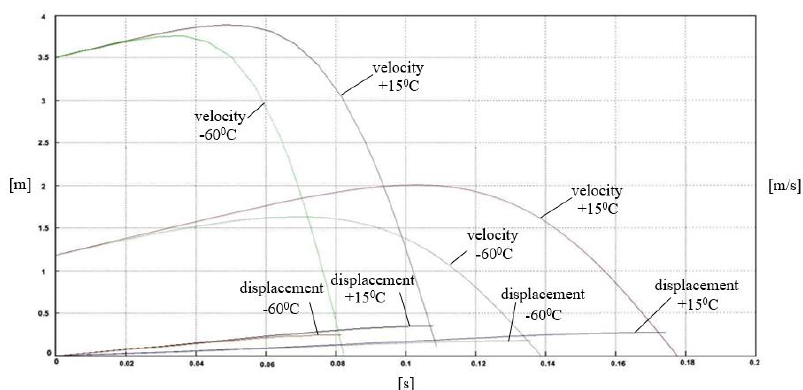
Figure 14. Displacement (blue line) and velocity of the buffer (orange line) at an operating higher speeds the percentage of the increase is lower. temperature of −60 °C, an impact speed of v 0 = 3.5 m/s, and 𝜂 𝐶𝑇 = 0.7 .